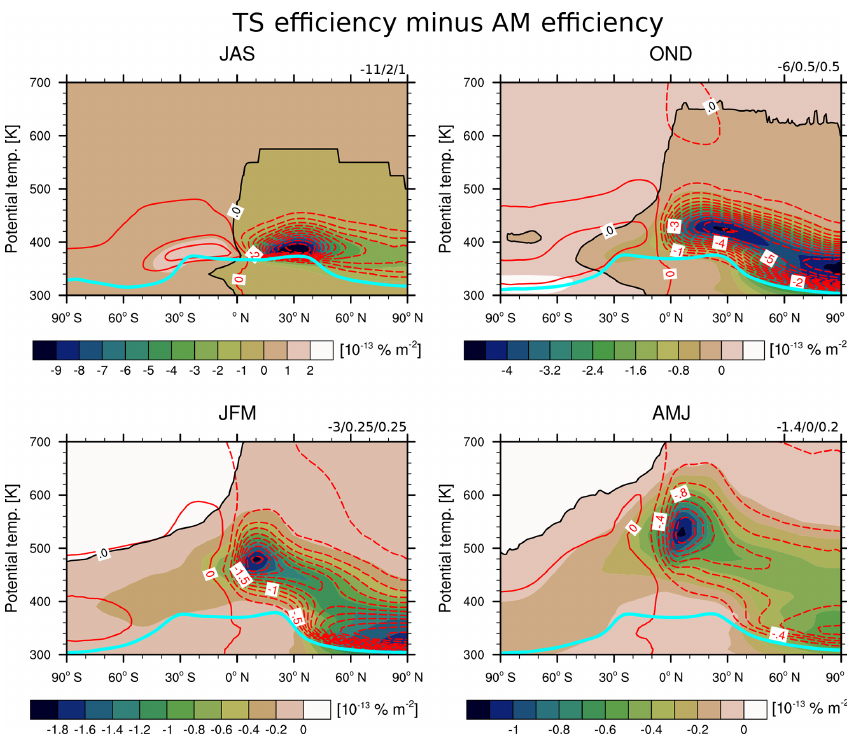
Figure 10. As in Fig. 5 but the difference of TS minus AM tracer contributions normalized by the respective source region area to yield the difference in efficiency (in 10 − 13 %m − 2 ). Water vapour results are contoured in red (negative contours are dashed), whereas the mass tracer differences are colour-coded. The blue lines represent the mean WMO tropopause based on ERA-Interim data. Note that the colour bar changes throughout the panels and that the largest negative differences are coloured in dark colours. The black line shows the zero contour of the mass tracer to guide the eye.